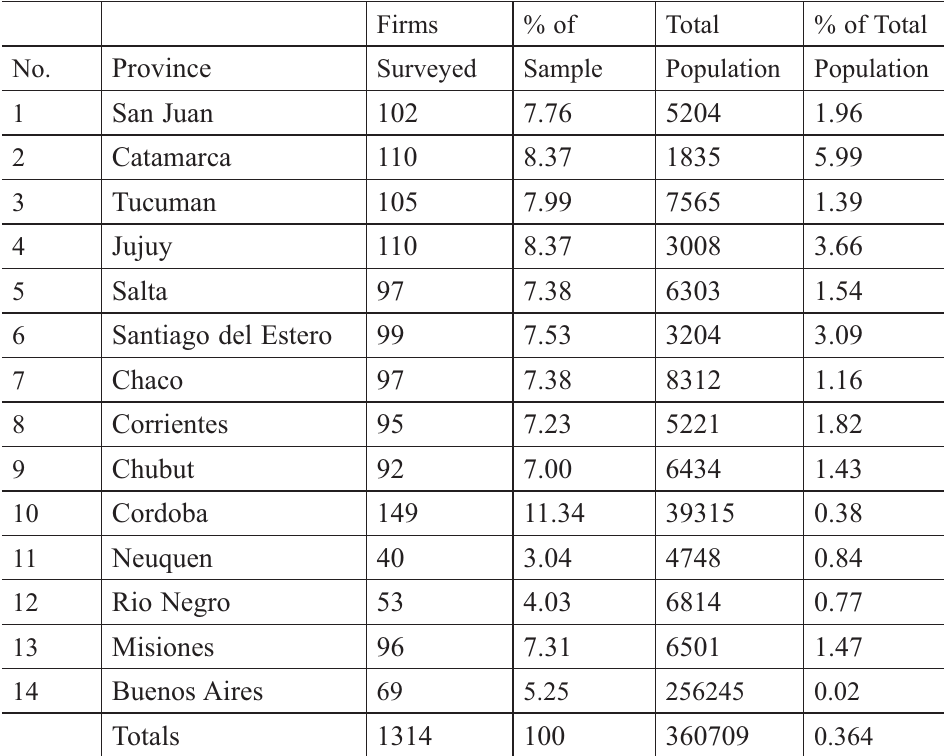
Table 2. Sample representativeness by